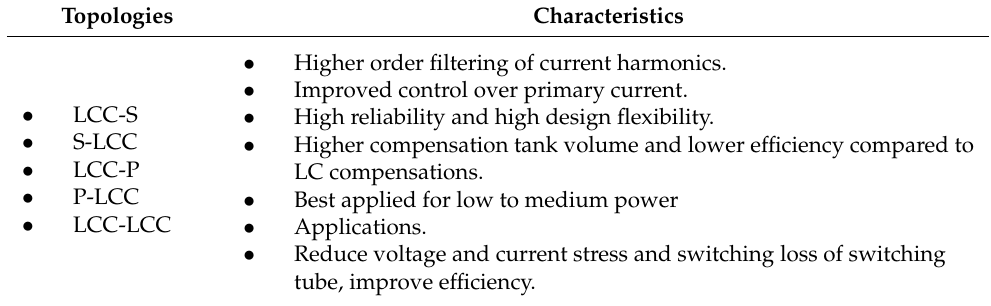
Table 3. Basic LCC compensations in WPT.